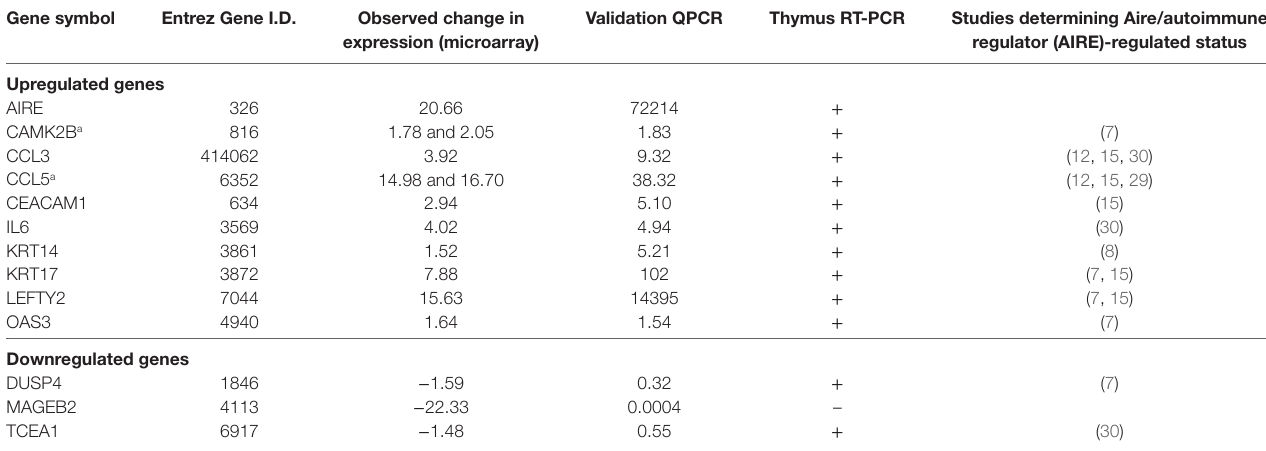
TaBle 2 | List of genes identified to be regulated in an autoimmune regulator (AIRE)-dependent manner in this study and showing at least one other study and analyzed in validation by QPCR and RT-PCR. gene symbol entrez gene i.D.